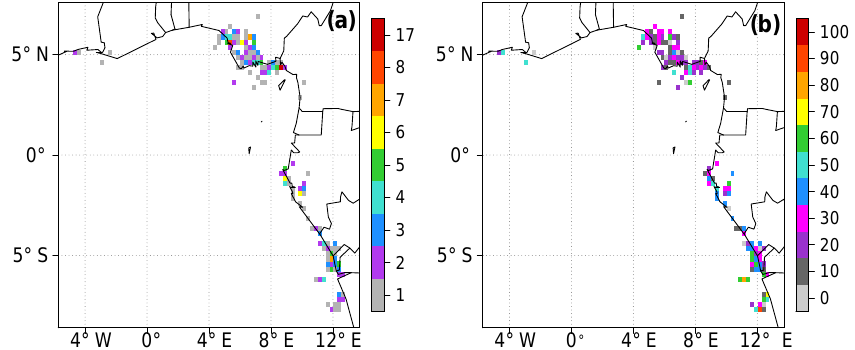
Figure 2. (a) Number of flares per flare box and (b) flaring activity (%) per flare box within TP15. A flaring activity of 100% means that every day in the 61-day period in June/July flaring was detected.